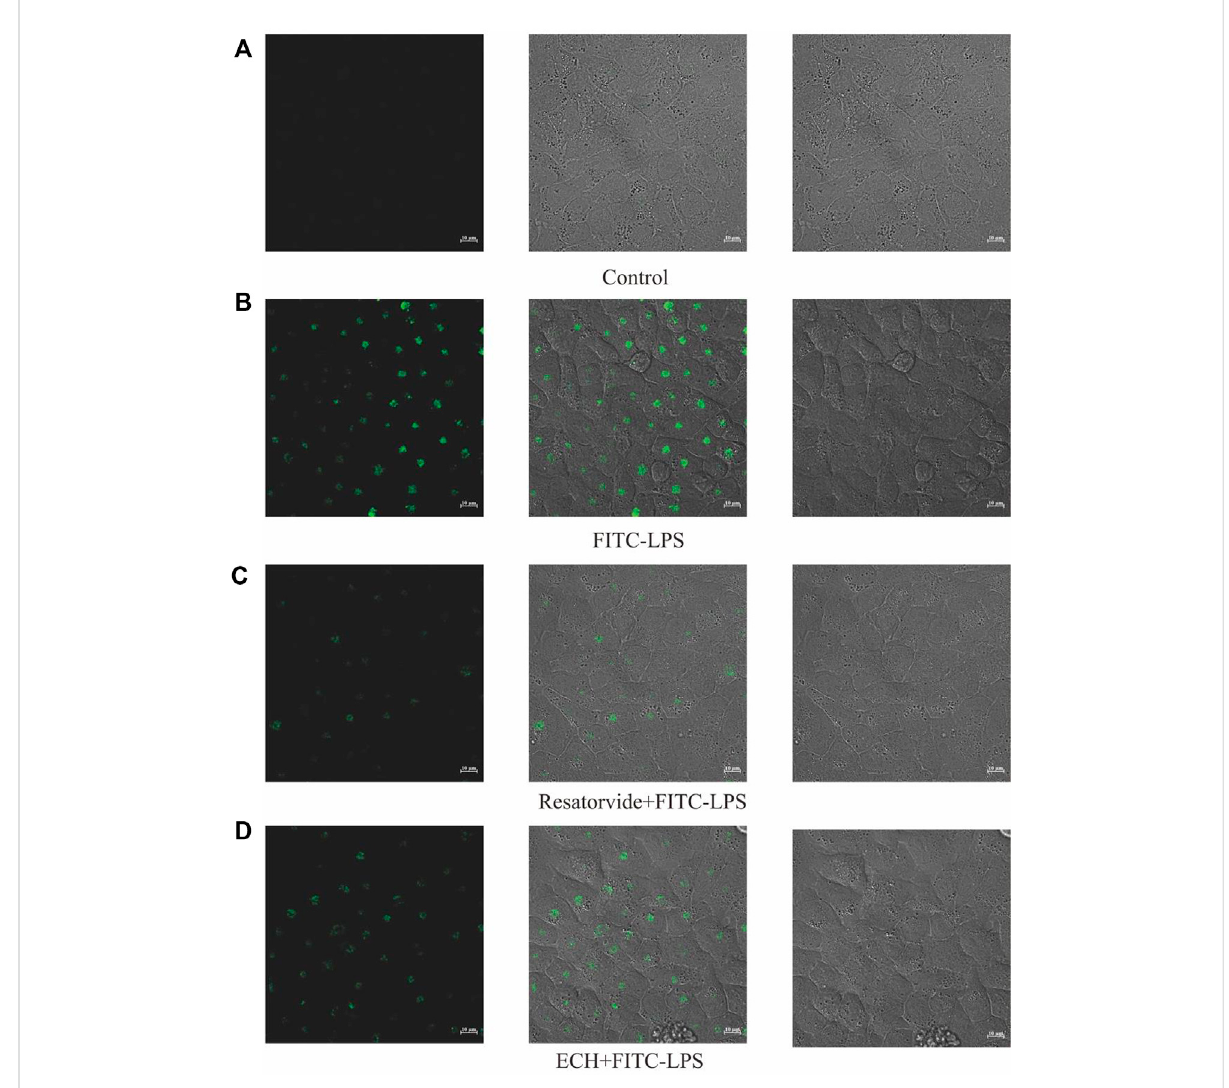
FIGURE 12 Effects of ECH on competitive inhibition of FITC-LPS binding cells. (A) Control group; (B) FITC-LPS group; (C) resatorvide+FITC-LPS group (TLR4 antagonist); (D) ECH+FITC-LPS